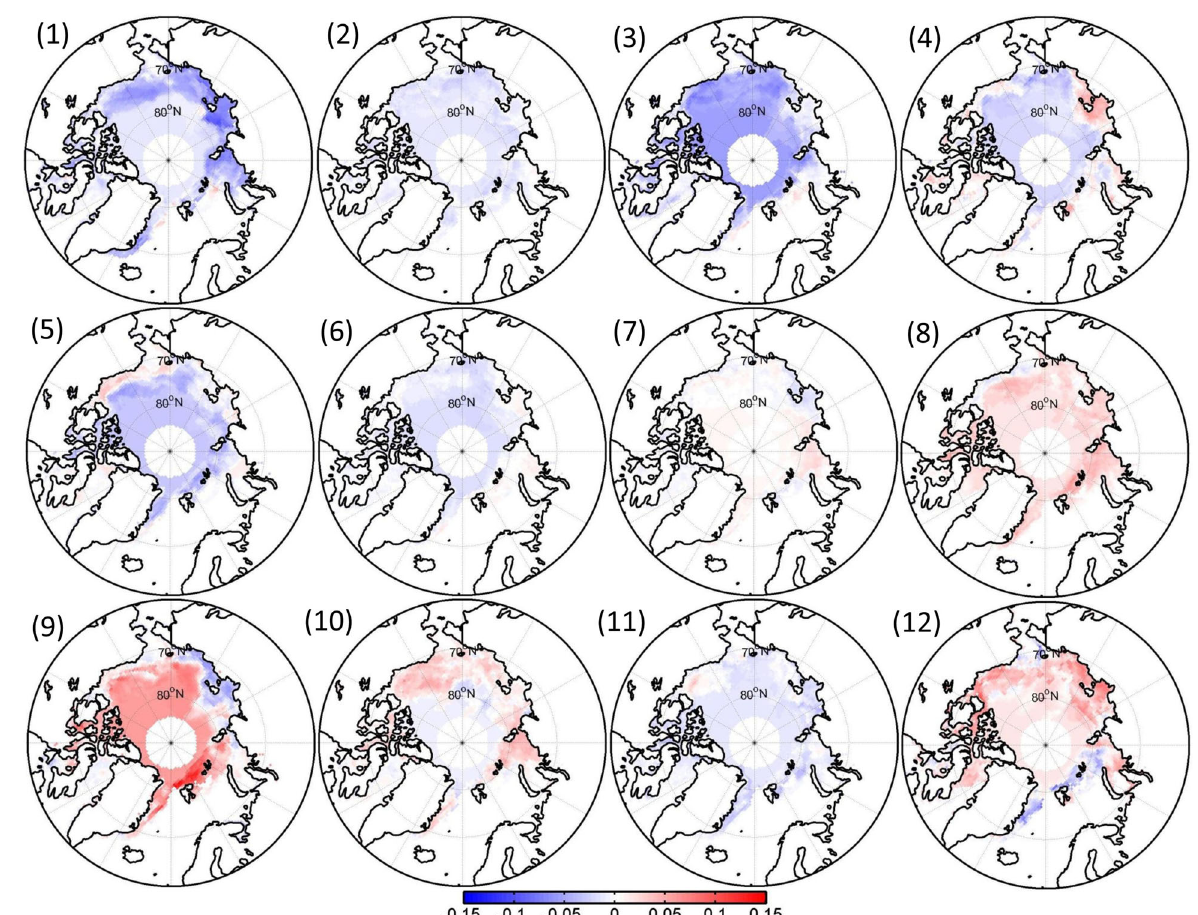
Fig. 7 Contribution from the interaction components to the trends in the number of August – October Arctic sea ice days for each of the 12 SOM nodes (units: day yr − 1